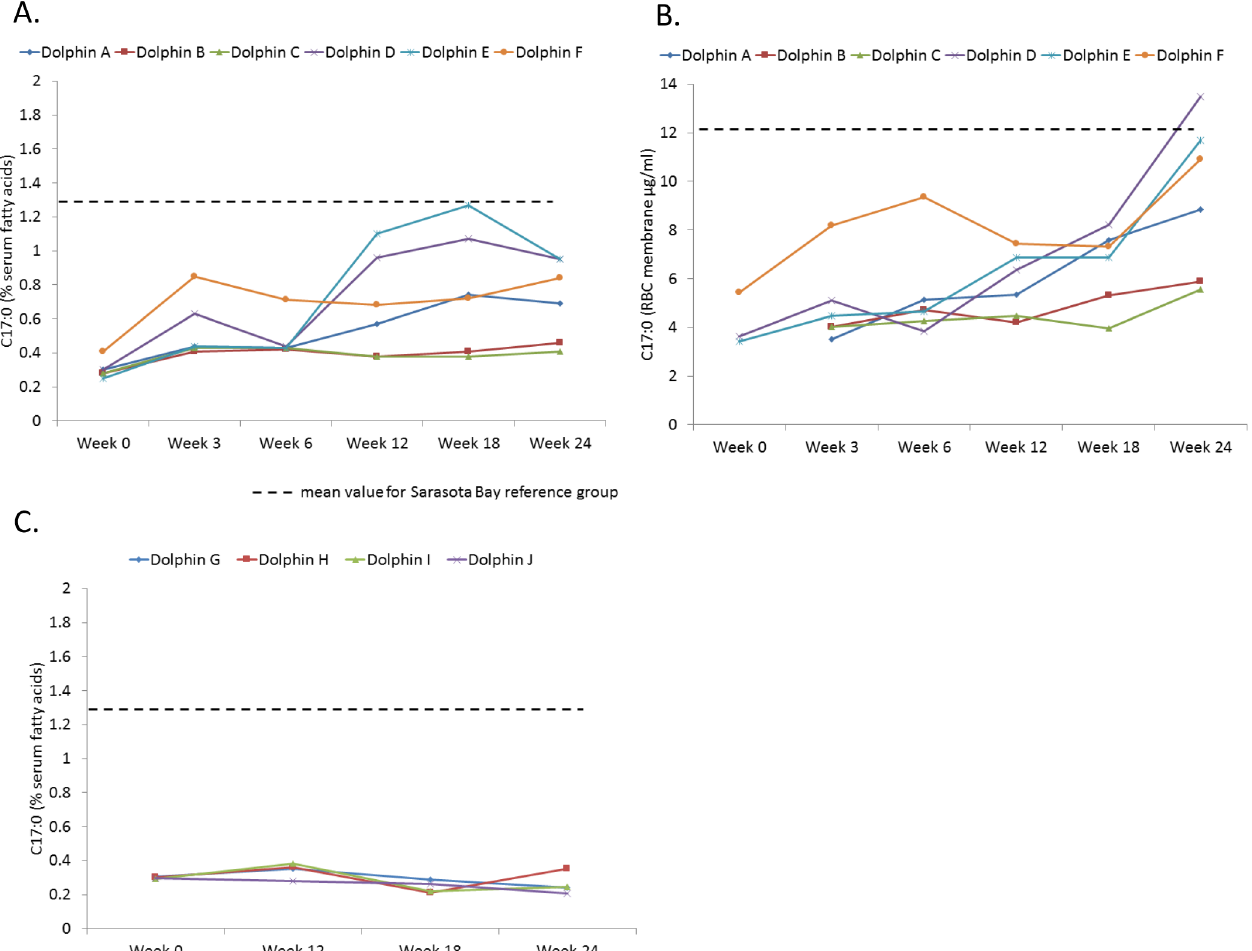
Fig 1. Heptadecanoic acid (C17:0) levels in bottlenose dolphins during a 24-week feeding study, including A) percent serum C17:0 of dolphins on a modified diet with an average increased dietary C17:0 intake from 400 to 1,700 mg/day (n = 6), B) total erythrocyte membrane C17:0 levels of dolphins on the modified C17:0 diet (n = 6), and C) percent serum C17:0 of reference dolphins not on modified diet (n = 6). The dashed line indicates the mean value for the Sarasota Bay reference group.